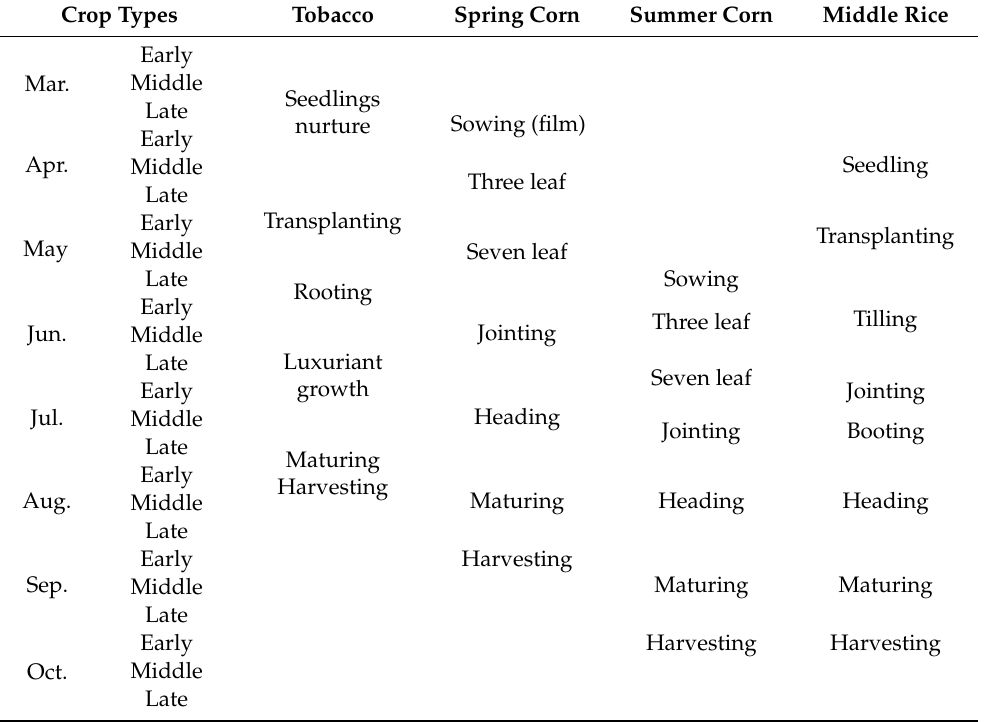
Figure 1. Study area location. Table 1. The phenological calendar of crops in the study area.